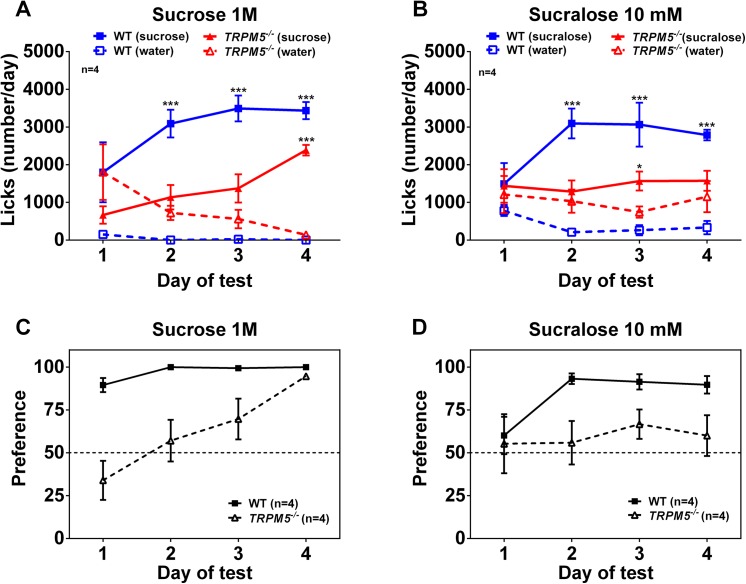
Lickometer taste preference test in male Trpm5
-/- and wild type mice.Preferences of 1M sucrose or 10 mM sucralose over water were followed during 4 consecutive days. Average daily number of licks of water and 1M sucrose (A) or 1 mM sucralose (B) for Trpm5
-/- and wild type mice were calculated. A preference score (percent licks on the test solution of the total number of licks) were calculated for 1M sucrose (C) and 10 mM sucralose (D). The dashed line (50% preference) indicates when the mouse consume equal amount of water and liquid tastant. Data are presented as mean ± SEM, n = 4, *** p<0.001, water vs sweetener within the same genotype (Students t-test).